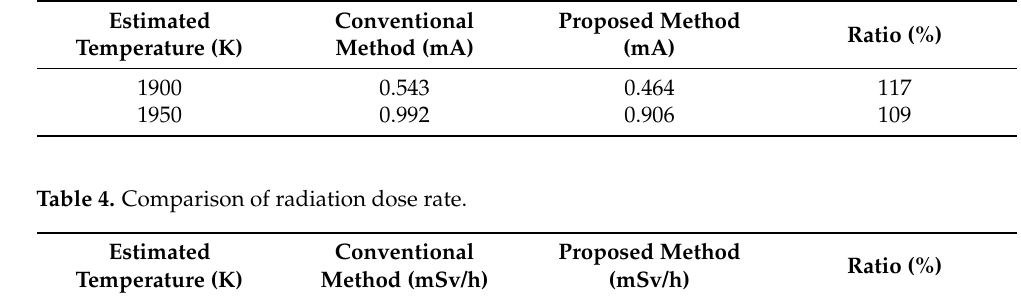
Table 3. Comparison of the conventional and proposed methods in terms of the average tube current.